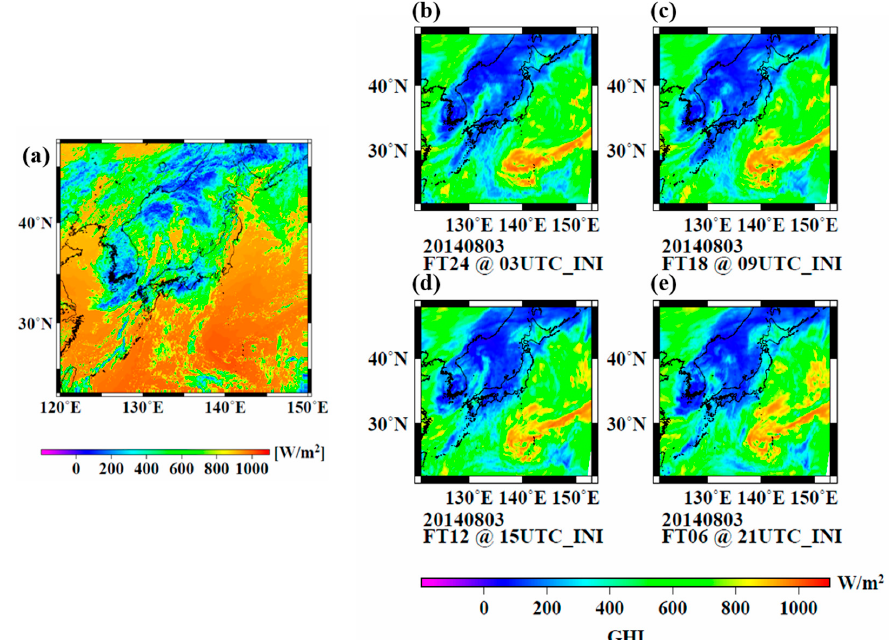
Figure 3. ( a ) Satellite-estimated GHI (AMATERASS data) at 12 JST on 4 August 2014. MSM GHI